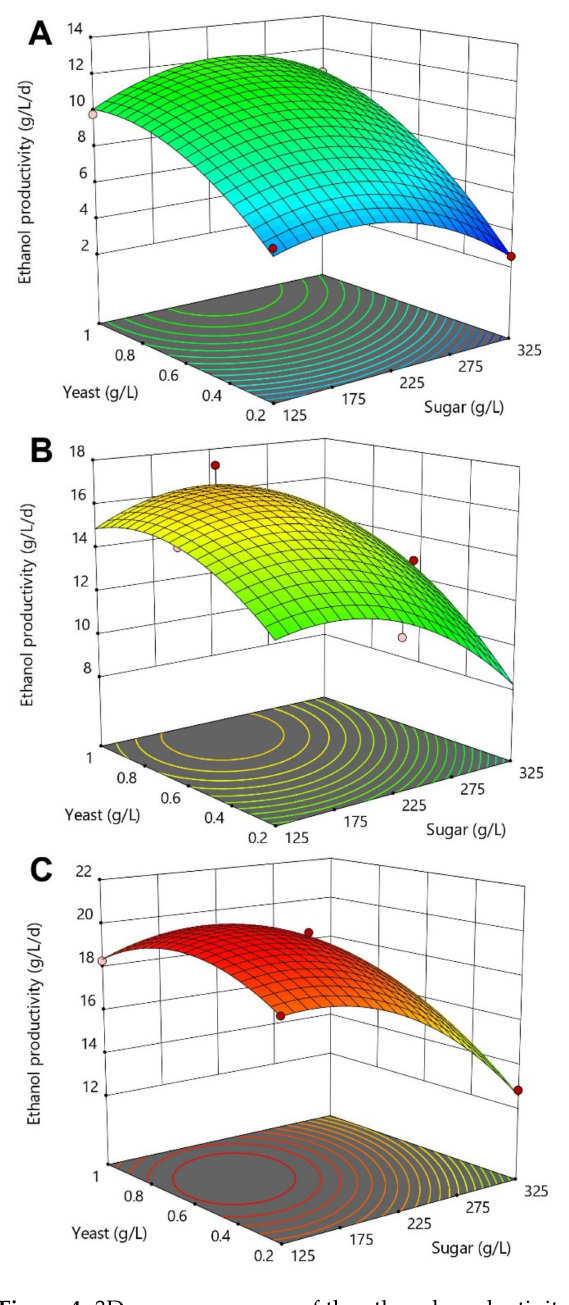
Figure 4. 3D-response curves of the ethanol productivity as a function of yeast and sugar concen- trations for the three investigated nutrient concentrations of 0 ( A ), 2 ( B ) and 4 g/L ( C ). Untreated sugar beet molasses, diluted at several initial sugar concentration, was used as the fermentation feedstock. Red dots within the response curves represent experimental design points obtained during the CCD-RSM while contour lines show prediction outputs calculated by the mathematical